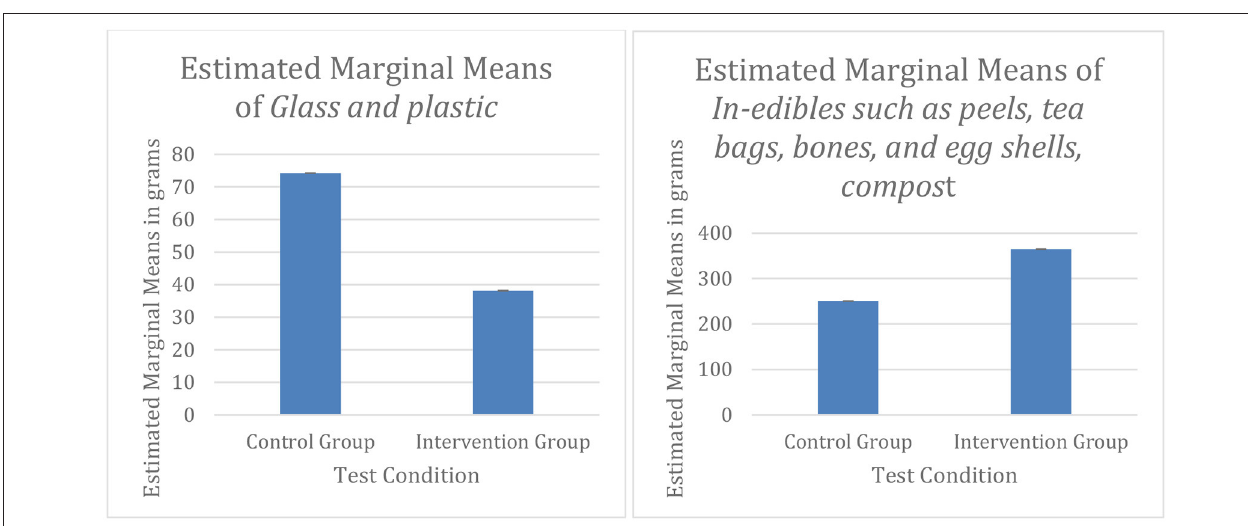
FIGURE 9 | Average amounts (in grams) of both significant waste types generated by the control vs. intervention group for the variables contamination with glass and plastics (left) and in-edibles (right).